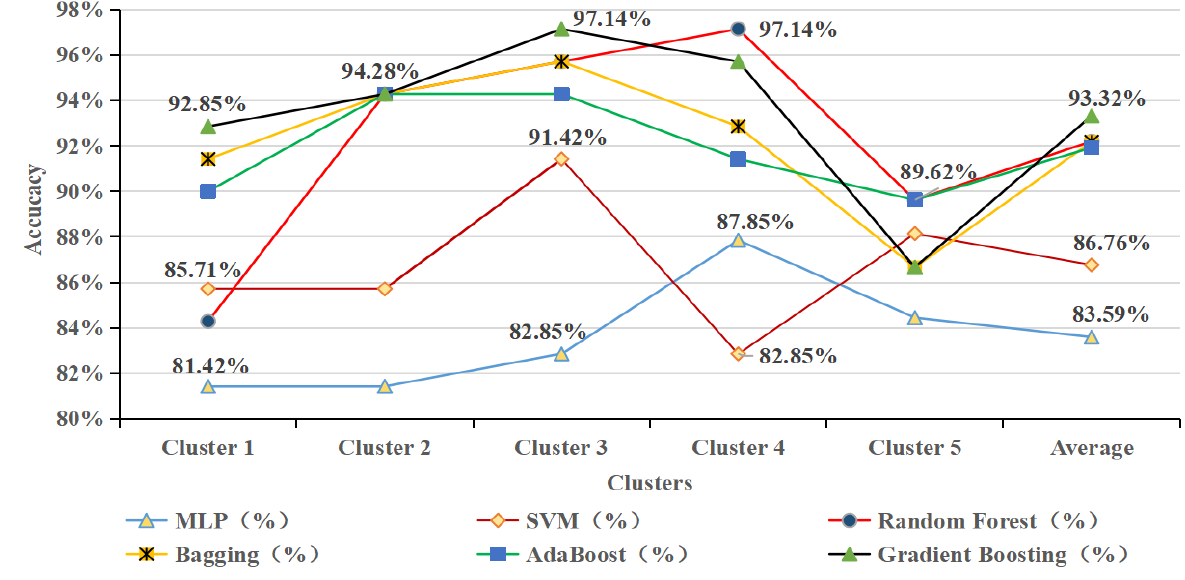
Figure 6. K-fold Cross-Validation For Six Classifiers.